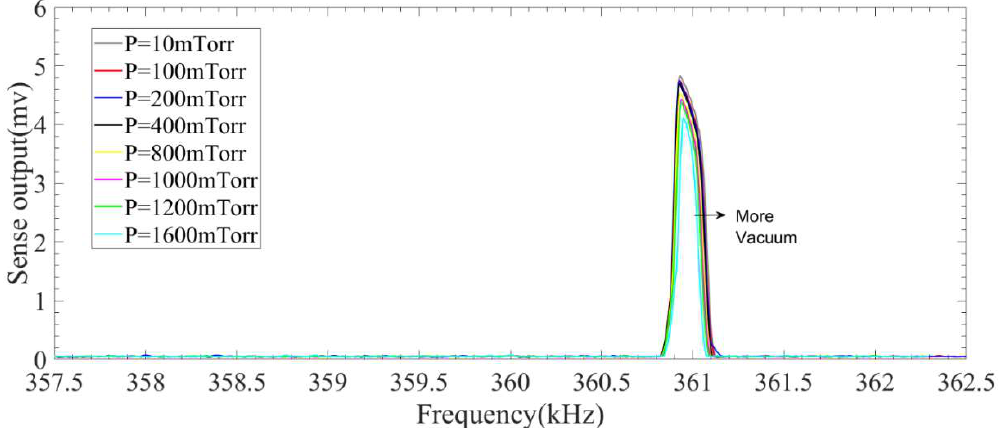
Figure 14. Effect of pressure on the performance of the system in the presence of internal resonance in a forward frequency sweep.